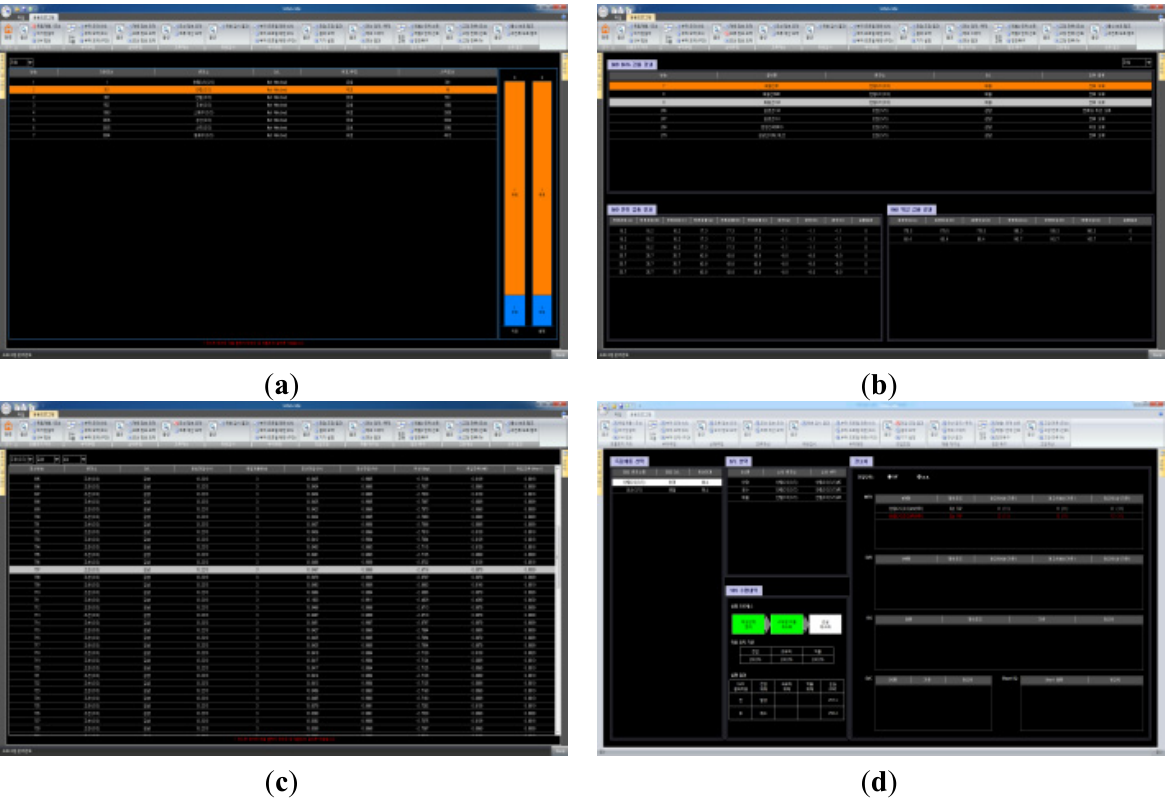
Figure 14. Result of application programs: ( a ) island creation of topology processor; ( b ) bad data detection of state estimator; ( c ) bus voltage calculation of real-time power flow; ( d ) control recommendation of voltage-VAr optimization; ( e ) restoration solution; ( f ) network reconfiguration solution; ( g ) protective coordination calculation; ( h ) short circuit